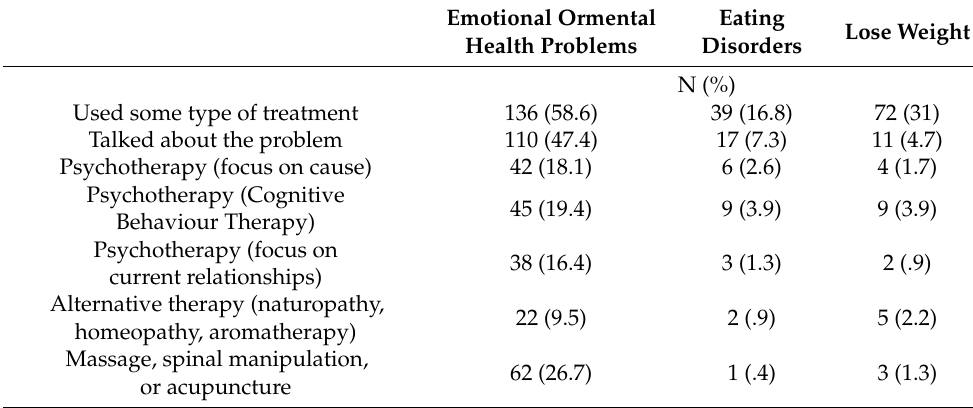
Table 2. Treatments or activities within the past 12 months prior to study (N =